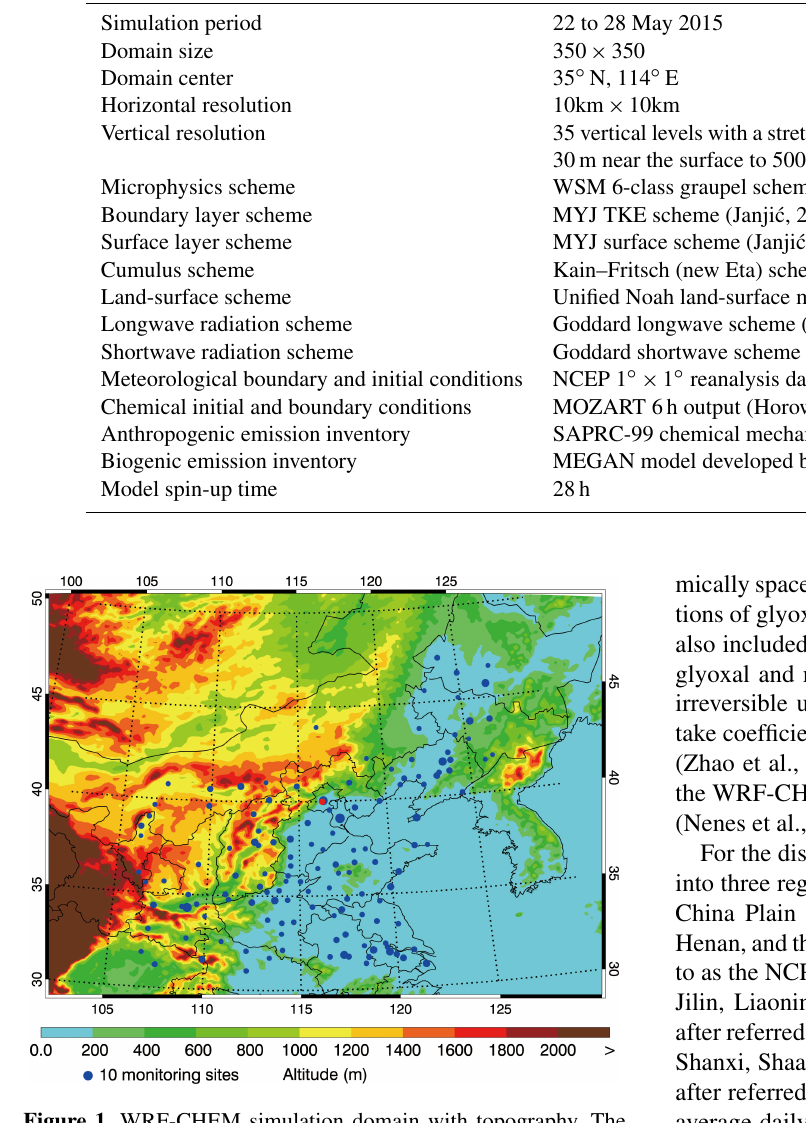
Figure 1. WRF-CHEM simulation domain with topography. The blue circles represent centers of cities with ambient monitoring sites and the red circle denotes the NCNST site. The size of the blue circle represents the number of ambient monitoring sites of